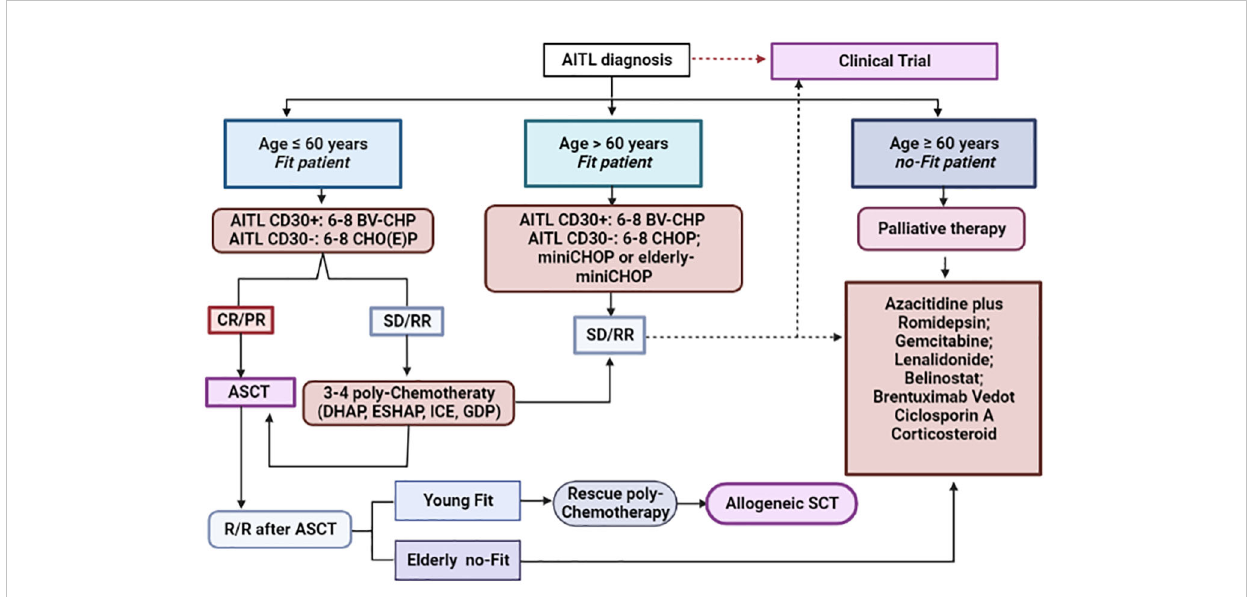
FIGURE 5 Therapeutic algorithm for the management of AITL patients. Up-front therapy and treatment of relapsed/refractory cases. *AITL, angioimmunoblastic T- cell lymphoma; BV-CHP, brentuximab-vedotin plus cyclophosphamide, doxorubicin and prednisone; CHO(E)P, cyclophosphamide, doxorubicin, vincristine, etoposide and prednisone; CR, complete response; PR, partial response; SD, stable disease; R/R, relapsed/refractory disease; ASCT, autologous stem cell transplantation; DHAP, dexamethasone, high-doses of cytarabine, cisplatin; ESHAP, etoposide, methylprednisolone, high-doses of cytarabine, cisplatin; ICE, ifosfamide, carboplatin, etoposide; GDP, gemcitabine, dexamethasone and